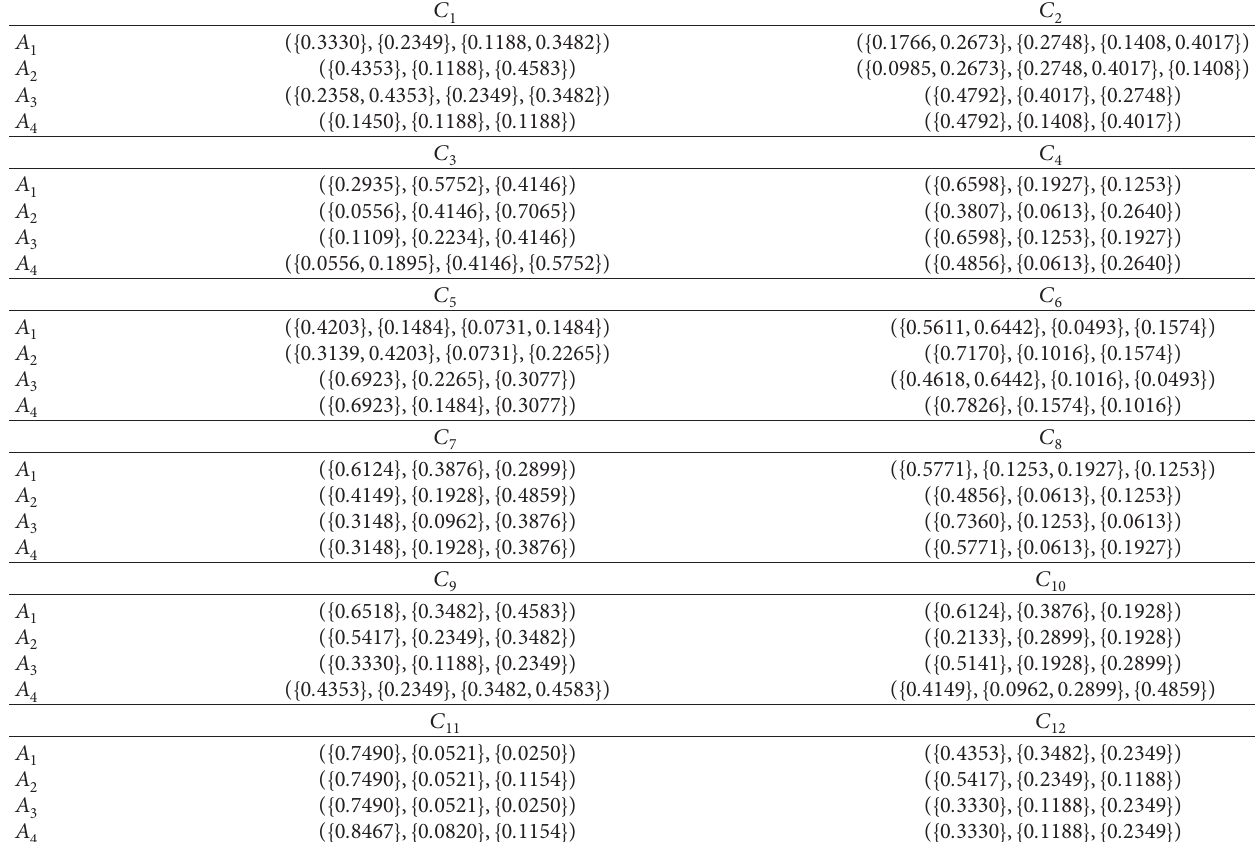
Table 2: Weighted single-valued neutrosophic hesitant fuzzy information.